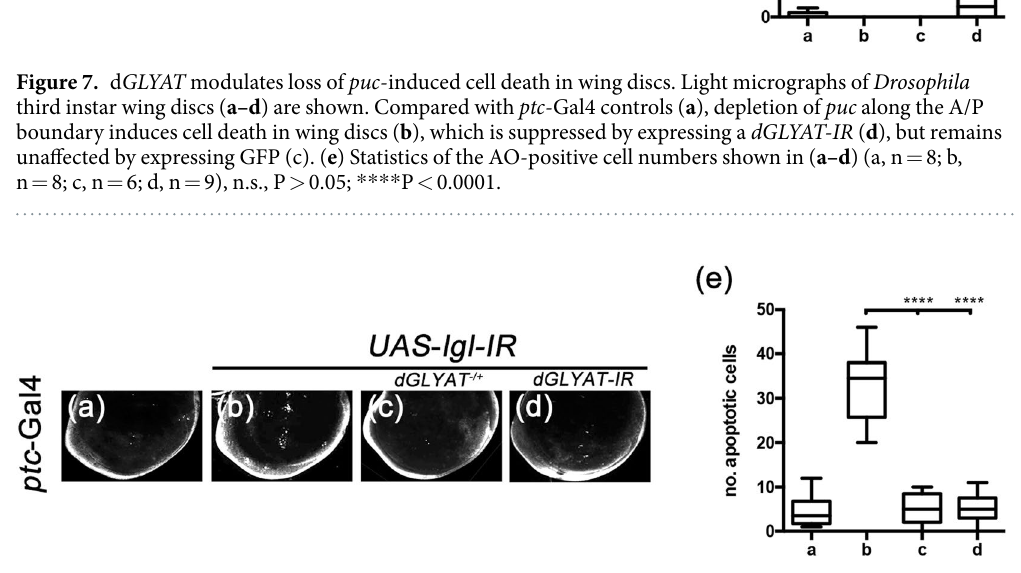
instar larval wing discs, as detected by AO staining (Fig. 7a and b). Intriguingly, the phenotype was significantly impeded by expressing a dGLYAT RNAi , but not GFP (Fig. 7c and d), suggesting dGLYAT is essential for physio- logically activated JNK-induced cell death. It has been reported that loss of cell polarity in wing disc epithelial results in JNK-mediated cell death 43, 44 . Consistently, knockdown the cell polarity gene lethal giant larva ( lgl ) by ptc -Gal4 promotes JNK-mediated cell death along the A/P boundary in third instar larval wing discs (Fig. 8b) 30, 31 . This phenotype was significantly sup- pressed in heterozygous dGLYAT mutant or by the expression of a dGLYAT RNAi (Fig. 8c–e). Therefore, dGLYAT modulates the physiological function of JNK signaling in development.